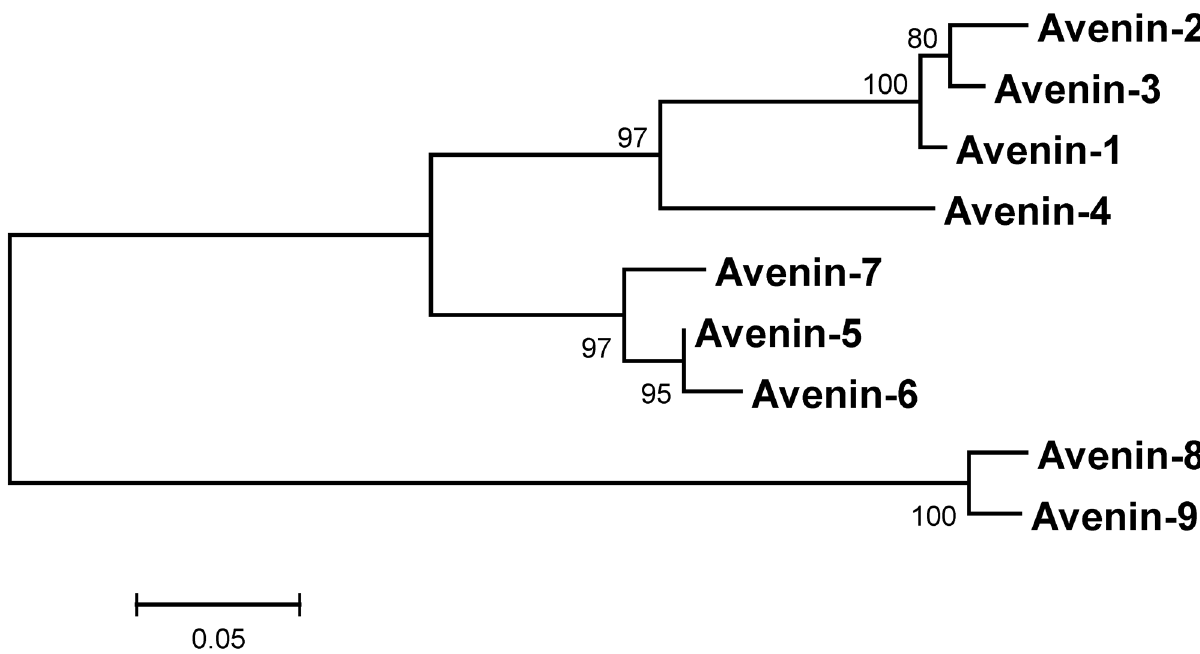
Figure 3. Phylogenetic tree of CDC Dancer avenins. The avenin amino acid alignment in Figure 1 is used to generate a phylogenetic tree by the Neighbor-joining algorithm. Tree validity was checked by bootstrap using 500 iterations.